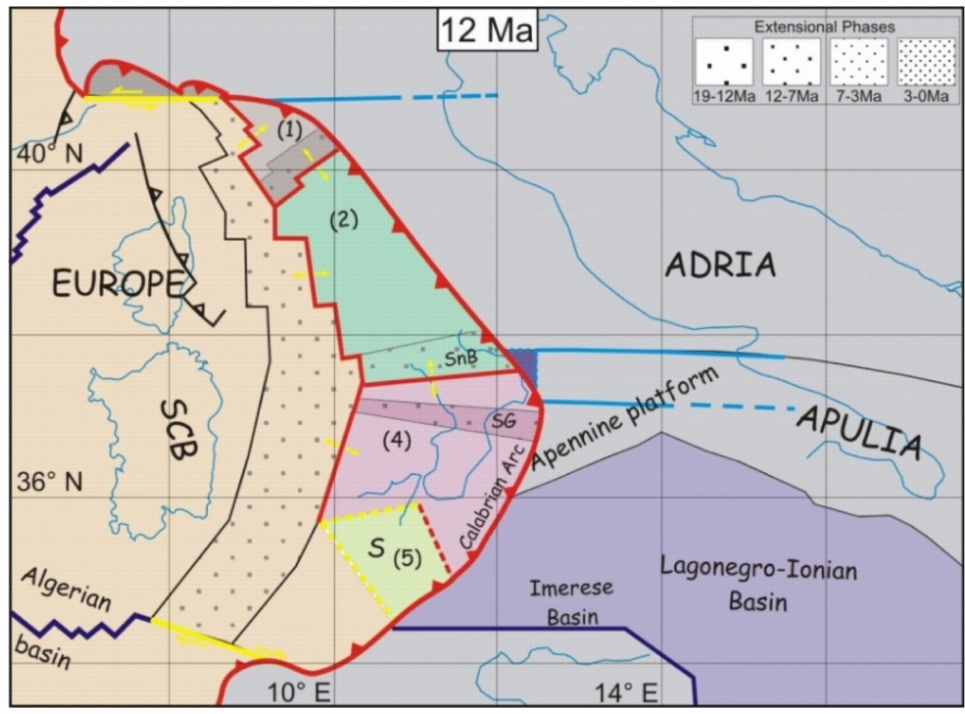
Figure 22. Plate reconstruction of the western Mediterranean region at 12 Ma. The Northern Sector ( 1 ) is shown in ( dark beige ); the Central Sector ( 2 ) is in ( green ); the Calabrian Arc Sector ( 4 ) is in ( pink ), the Sicilian Sector in light ( green ) ( 5 ). Dotted areas are in extension (see upper right legend). Dashed lines are incipient boundaries. ( Red lines ) are active boundaries. ( Black lines ) are inactive boundaries. ( Yellow lines ) are strike-slip faults. ( Light blue lines ) are transfer faults on the continental lithosphere and ( light blue dotted lines ) are the Jurassic COB (Continent Ocean Boundary). ( Dark blue lines ) are the Middle-Triassic COB. ( Yellow arrows ) indicate direction